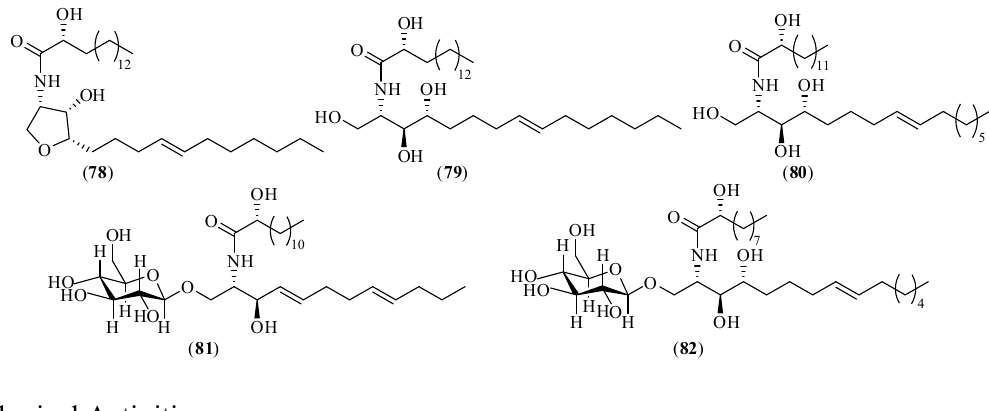
Figure 4. Chemical structures of the main ceramides and cerebrosides in CX: ( 78